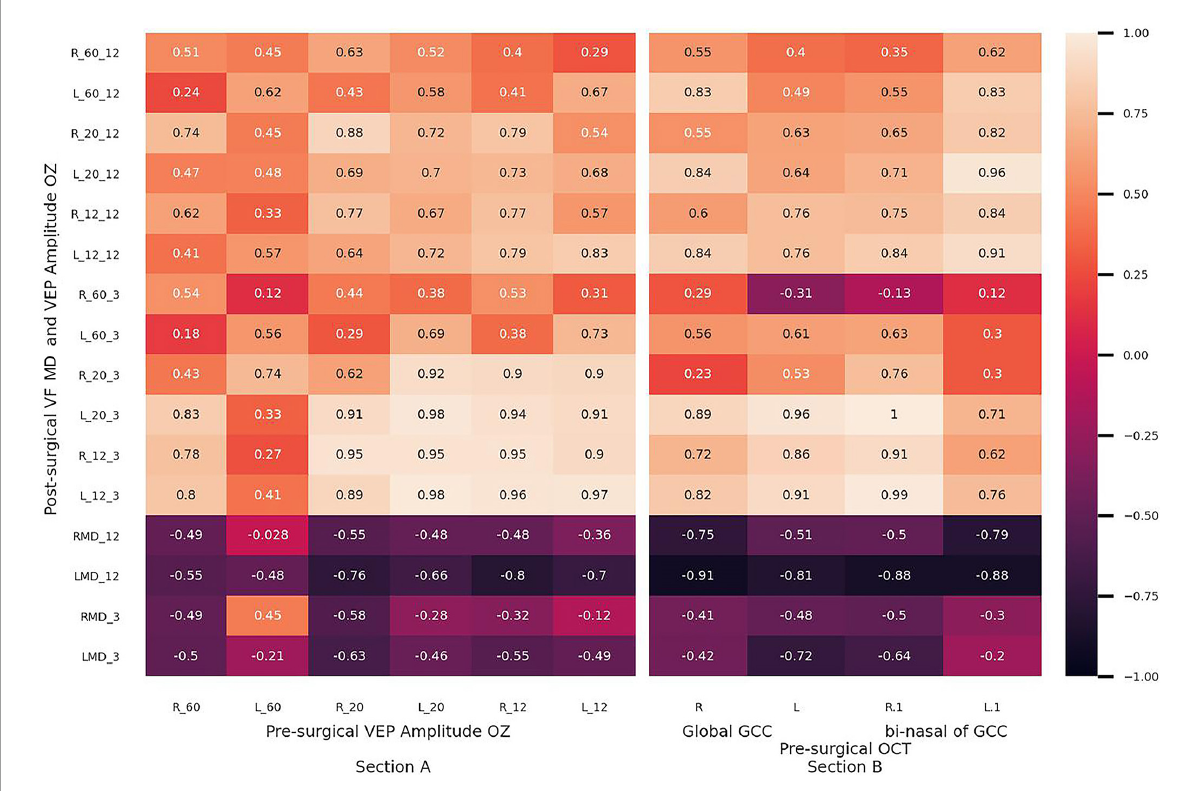
FIGURE3 Thermic diagrams show rho values of Spearman’s correlations between pre-surgical and post-surgical parameters. (Section A) Pre-surgical visual evoked potential amplitude: amplitude OZ vs. post-surgical visual field median deviation and visual evoked potential amplitude OZ at 3 and 12 months. (Section B) Pre-surgical global and bi-nasal of ganglion cell complex vs. post-surgical visual field median deviation and visual evoked potential amplitude OZ at 3 and 12 months. L: left eye, R: right eye. Bi-nasal of GCC: bi-nasal sectors of a ganglion cell